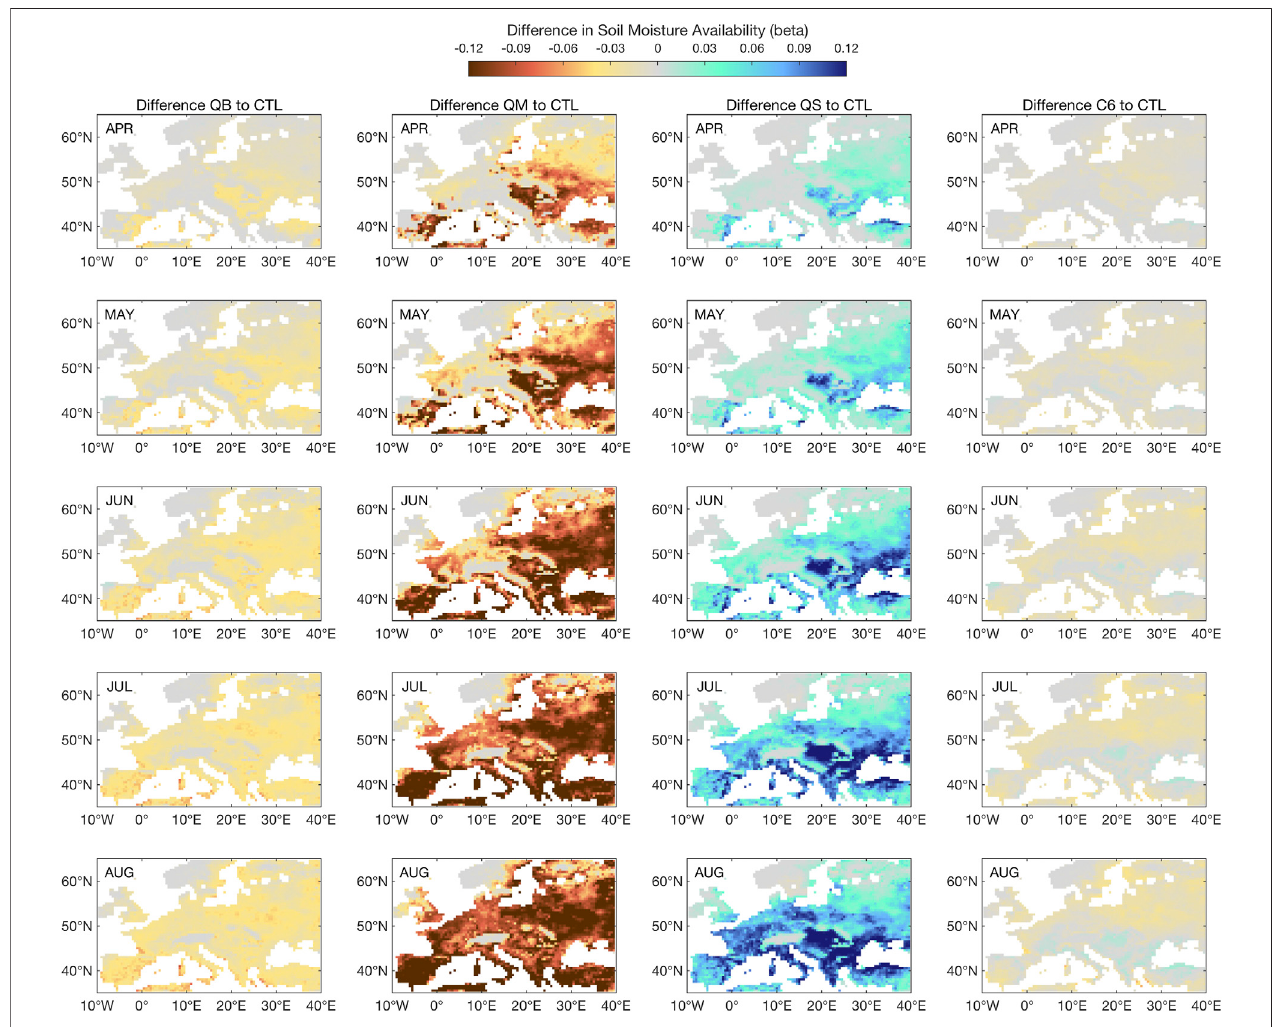
FIGURE11| Seasonalevolutionofavailablesoilmoistureresponsetothe2003heatwaveinallsimulations,ascomparedtoCTL.The2003seasonstartsatthetop row, with the April 2003 monthly mean response, and ends in August 2003, with the monthly mean response. ß is unitless.